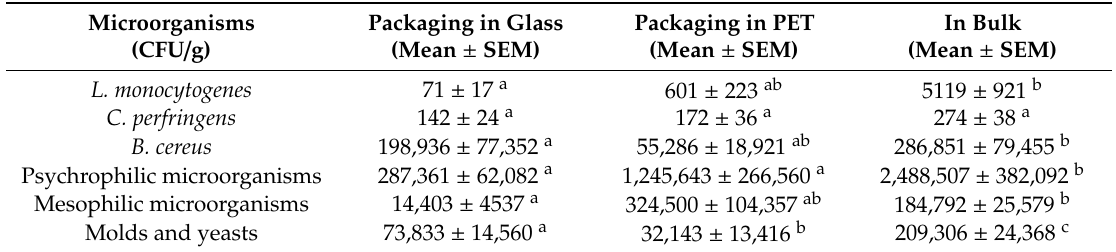
Table 3. Microbial count values (CFU / g) and standard error of the mean (SEM) for Listeria monocytogenes , Clostridium perfringens , Bacillus cereus , psychrophilic microorganisms, mesophilic microorganisms, and molds and yeasts in culture media previously infused with herbs (thyme, rosemary, cloves, oregano, and basil) according to the marketing system (in bulk, or in packaging in glass or PET).